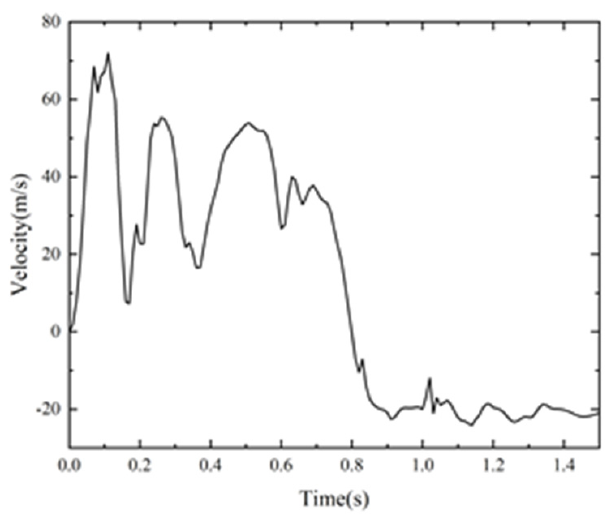
Figure 16. Velocity of tractor rocket.